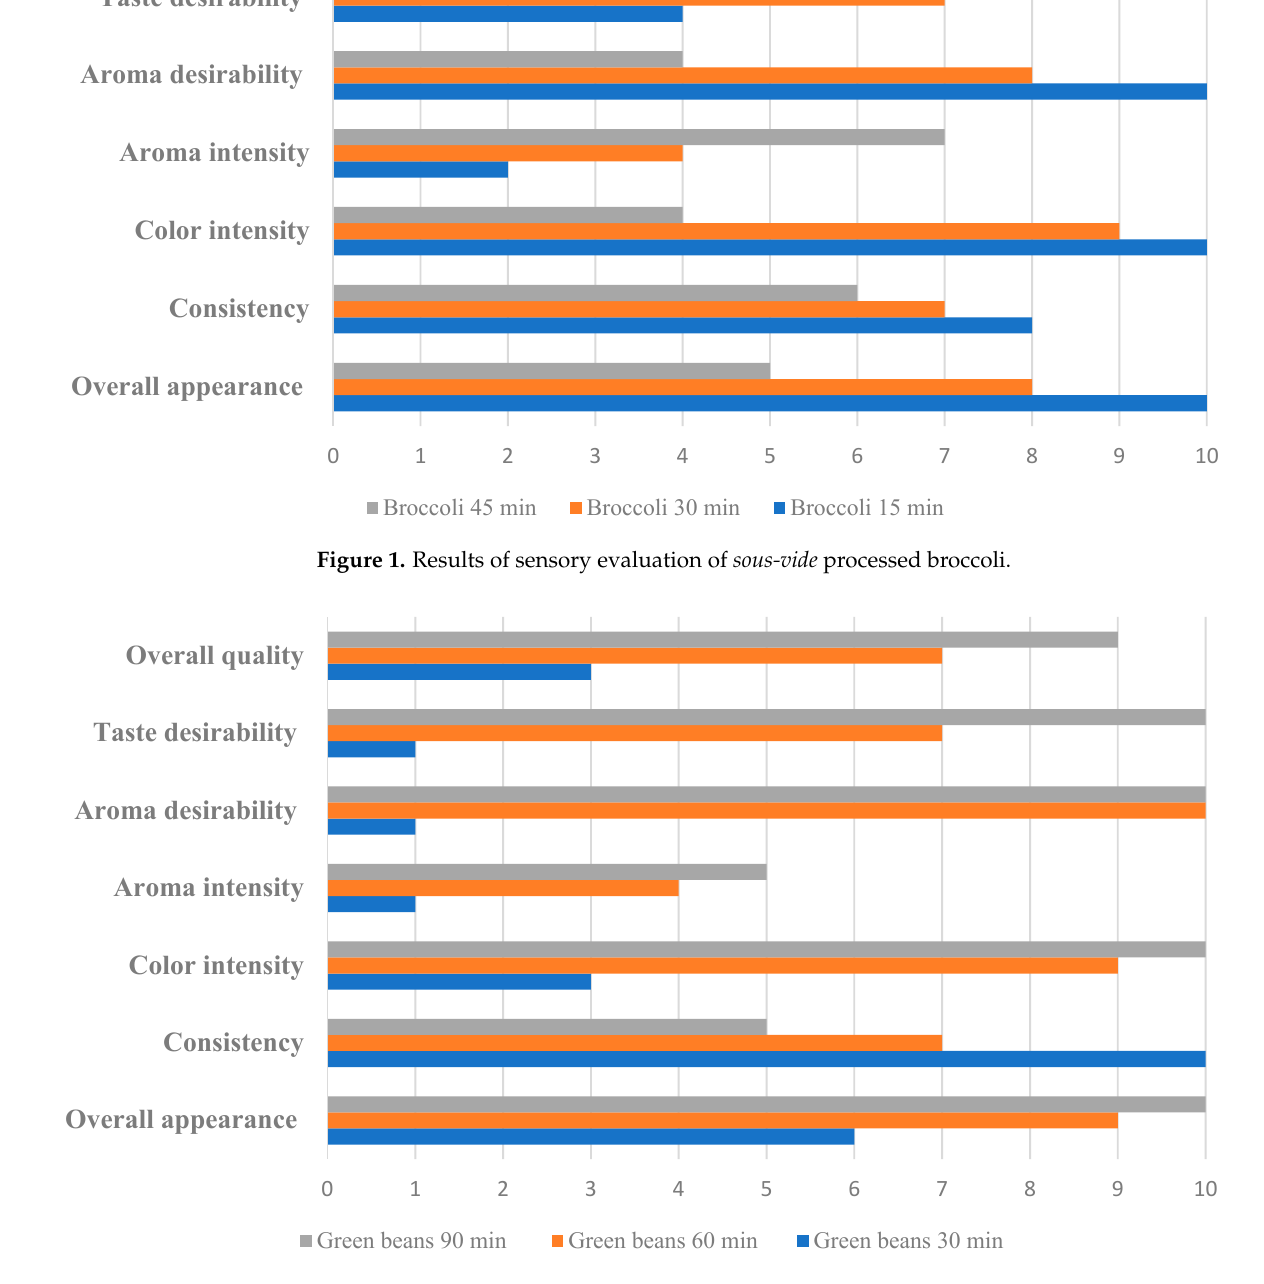
Figure 2. Results of sensory evaluation of sous-vide processed green beans.